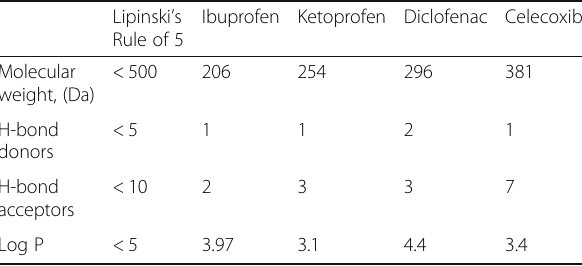
Table 1 Comparison of physical characteristics of select